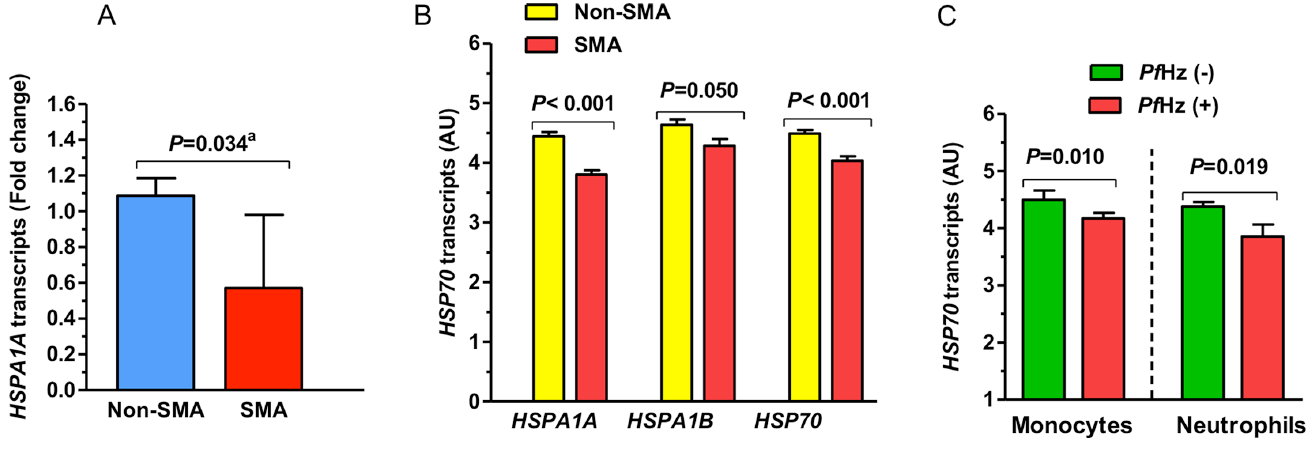
Figure 1. HSP70 gene expression in children with malaria . (A) Parasitemic children (n = 72) were categorized according to “polarized” phenotypic clinical categories of non-SMA (Hb 8.0–10.9 g/dL, n = 50) and SMA (Hb <5.0 g/dL, n = 22). Global gene expression profiling was performed on total RNA isolated from WBCs using the Illumina ® HumanHT-12 v4 beadchip array covering >47,000 transcripts. Panel